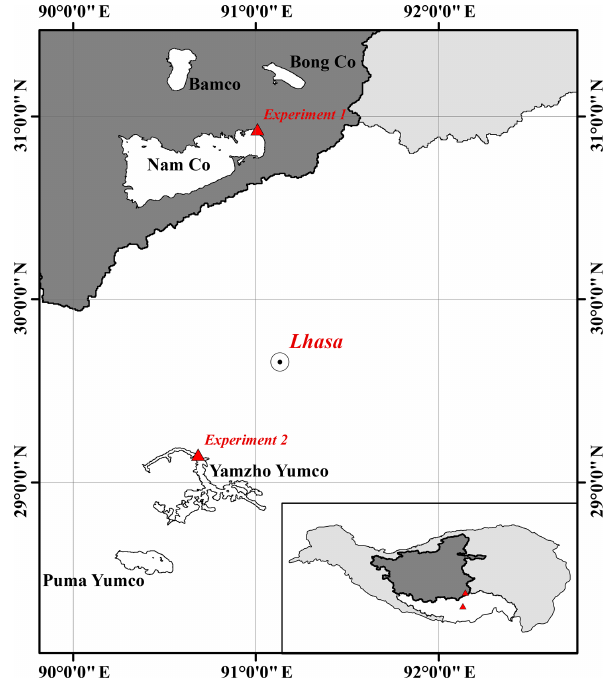
Figure 2. Experiment locations: Nam Co and Yamzhog Yumco. Nam Co is located in the endorheic basin of the TP, while Yamzhog Yumco is located in the Yarlung Zangbo river basin (the upper Brahmaputra River). Both lakes are close to Lhasa